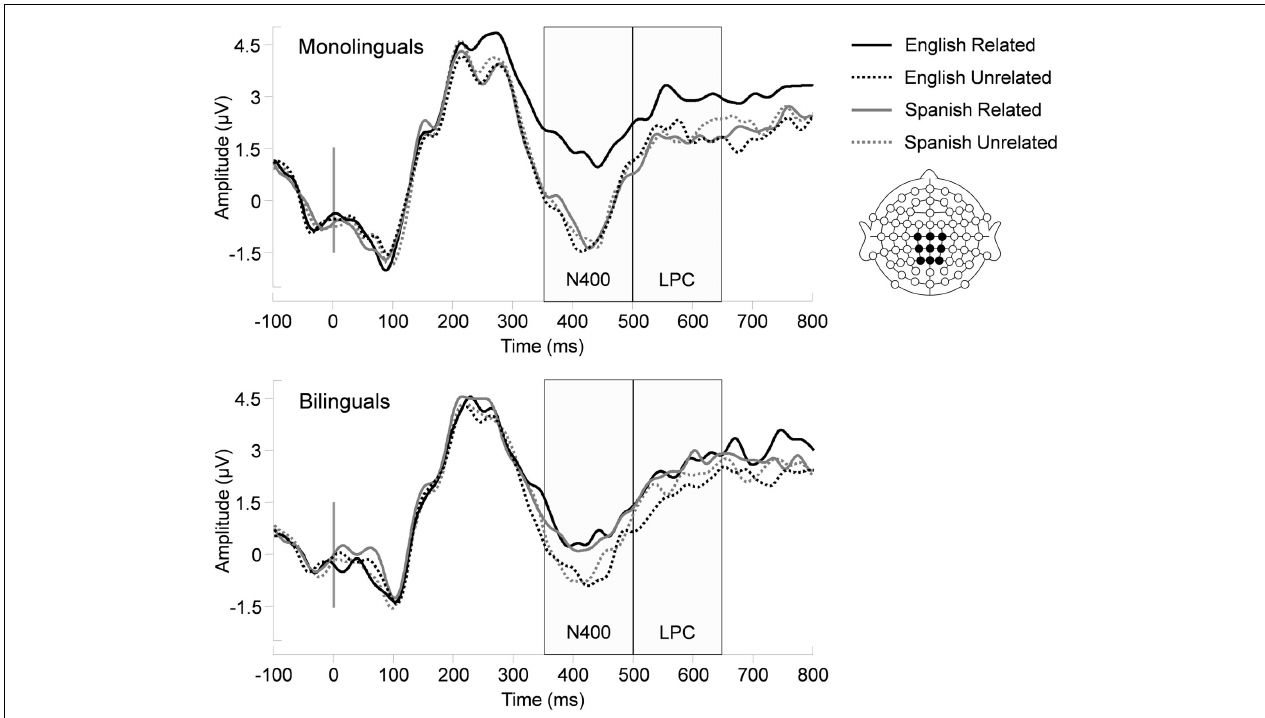
FIGURE 2 | ERPs measured over the centroparietal electrodes where N400 and LPC were maximal (a liner derivation of C1, Cz, C2, CP1, CPz, CP2, P1, Pz, P2) as a function of relatedness, homograph language, and language group.